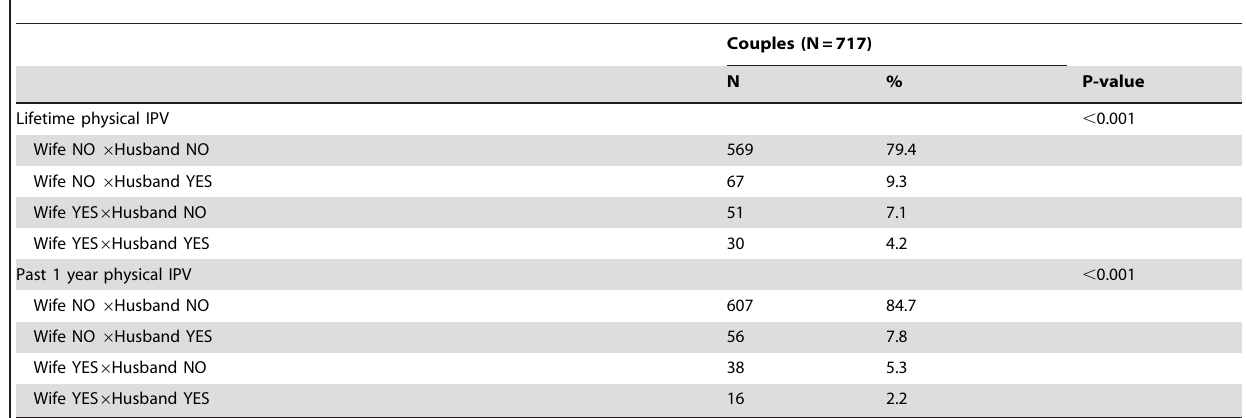
Table 3. Comparison of prevalence of lifetime and past one-year physical IPV among Nepalese